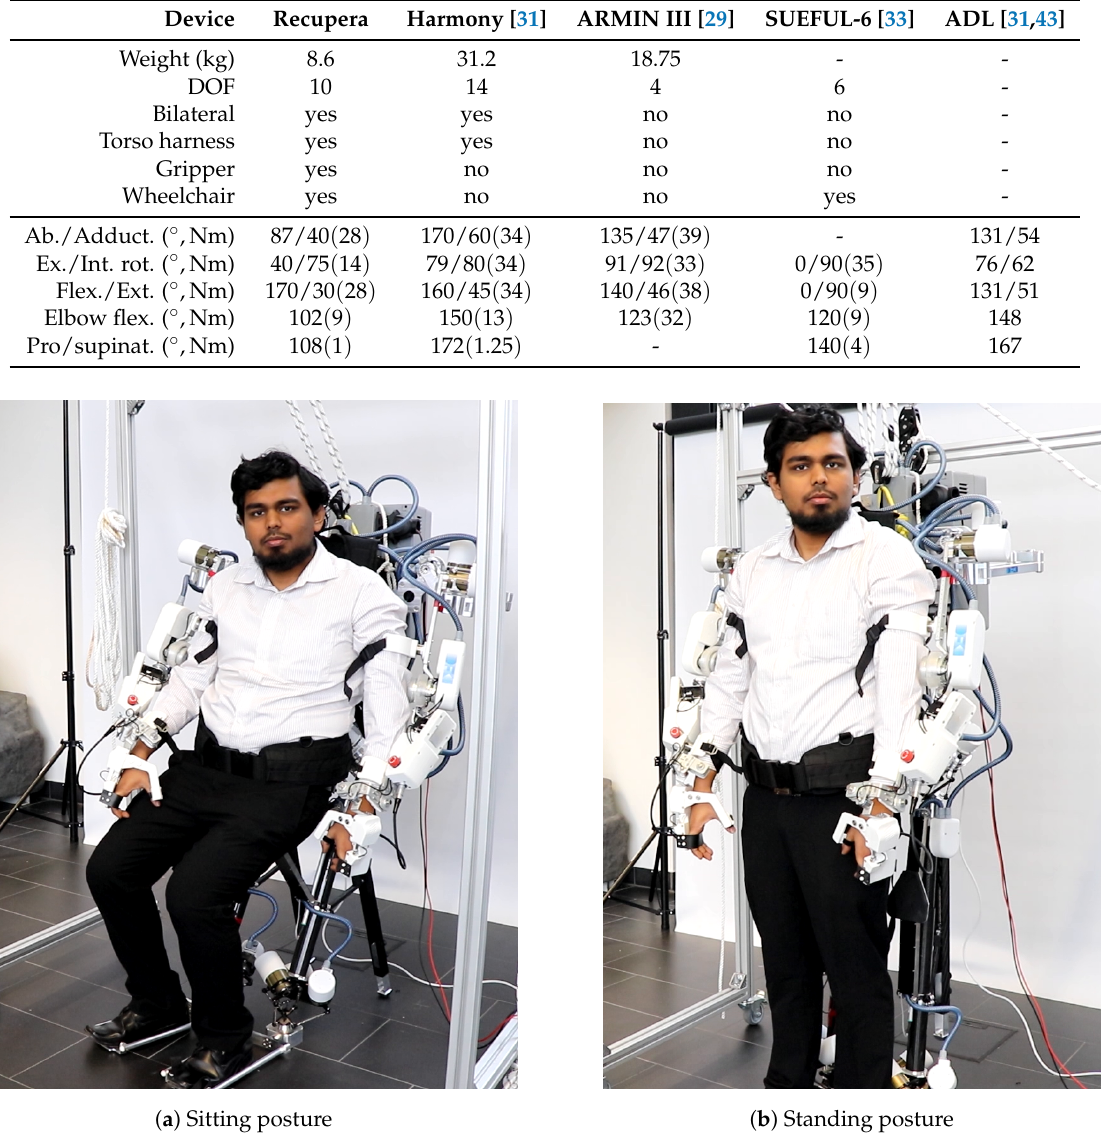
Table 4. Comparison of Recupera upperbody system to other upper body exoskeletons and the Activities of Daily Living (ADL) ROM.